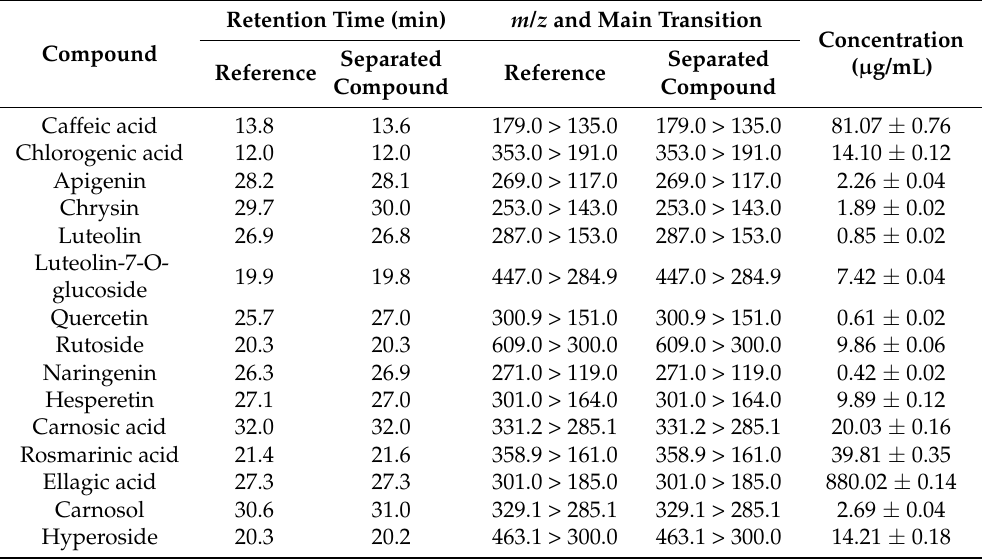
Table 2. Results obtained for the LC-MS analysis of R. officinalis -loaded